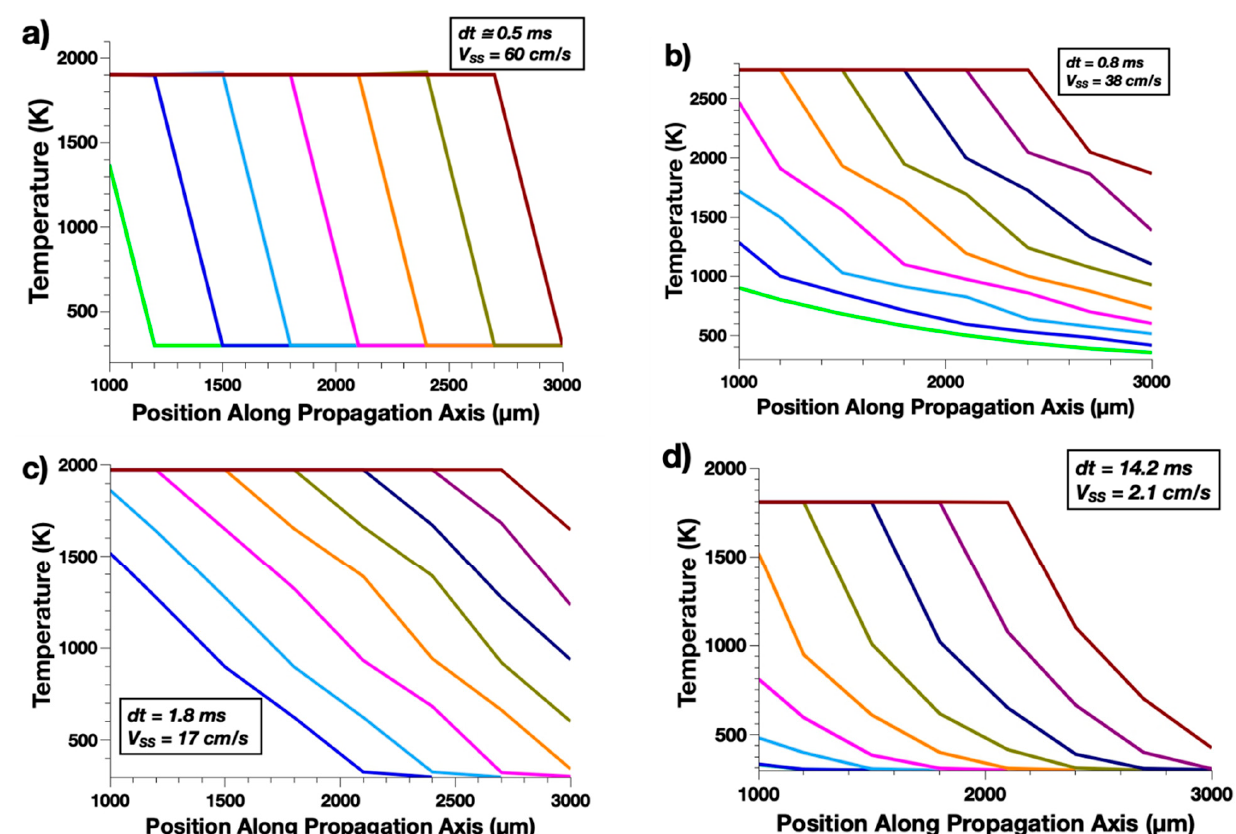
Figure 3. Temperature profiles taken at regular time intervals dt and calculated burn rate V SS for: ( a ) Al/CuO, ( b ) Al/Fe 2 O 3 , ( c ) Al/WO 3 , and ( d ) Al/Pb 3 O 4 .